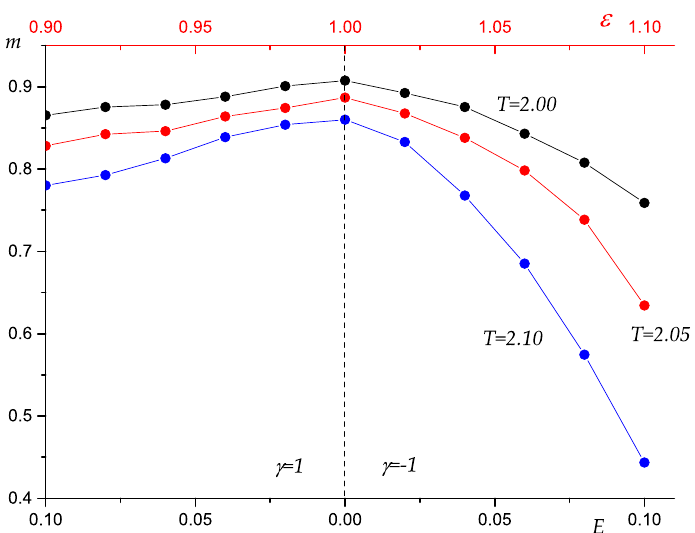
Figure 3. Dependence of the magnetization of a thin film on the strength of the external electric field at three different temperatures for A =